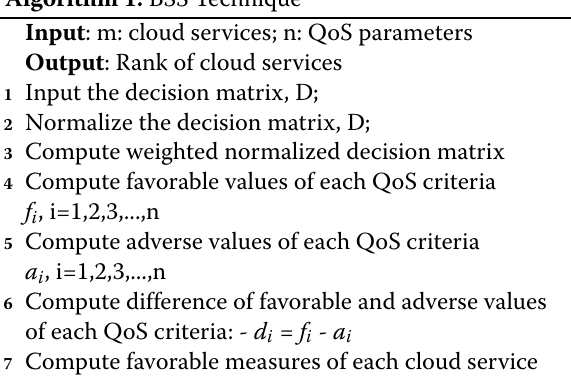
Table 3 Decision Matrix for Subjective